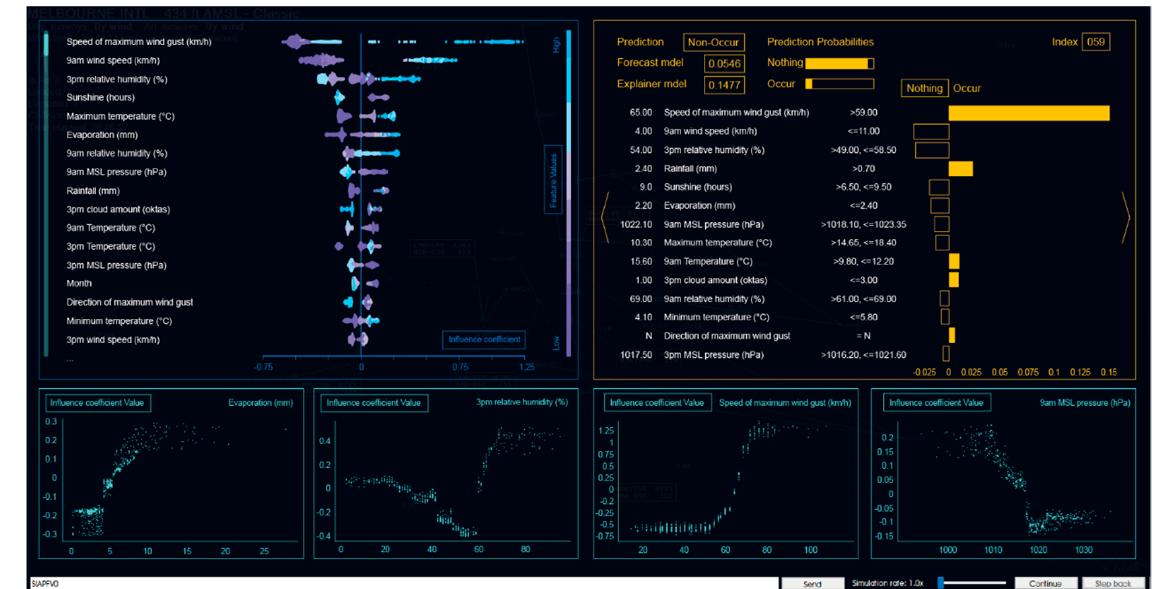
Figure 15. Explanation interface concept.